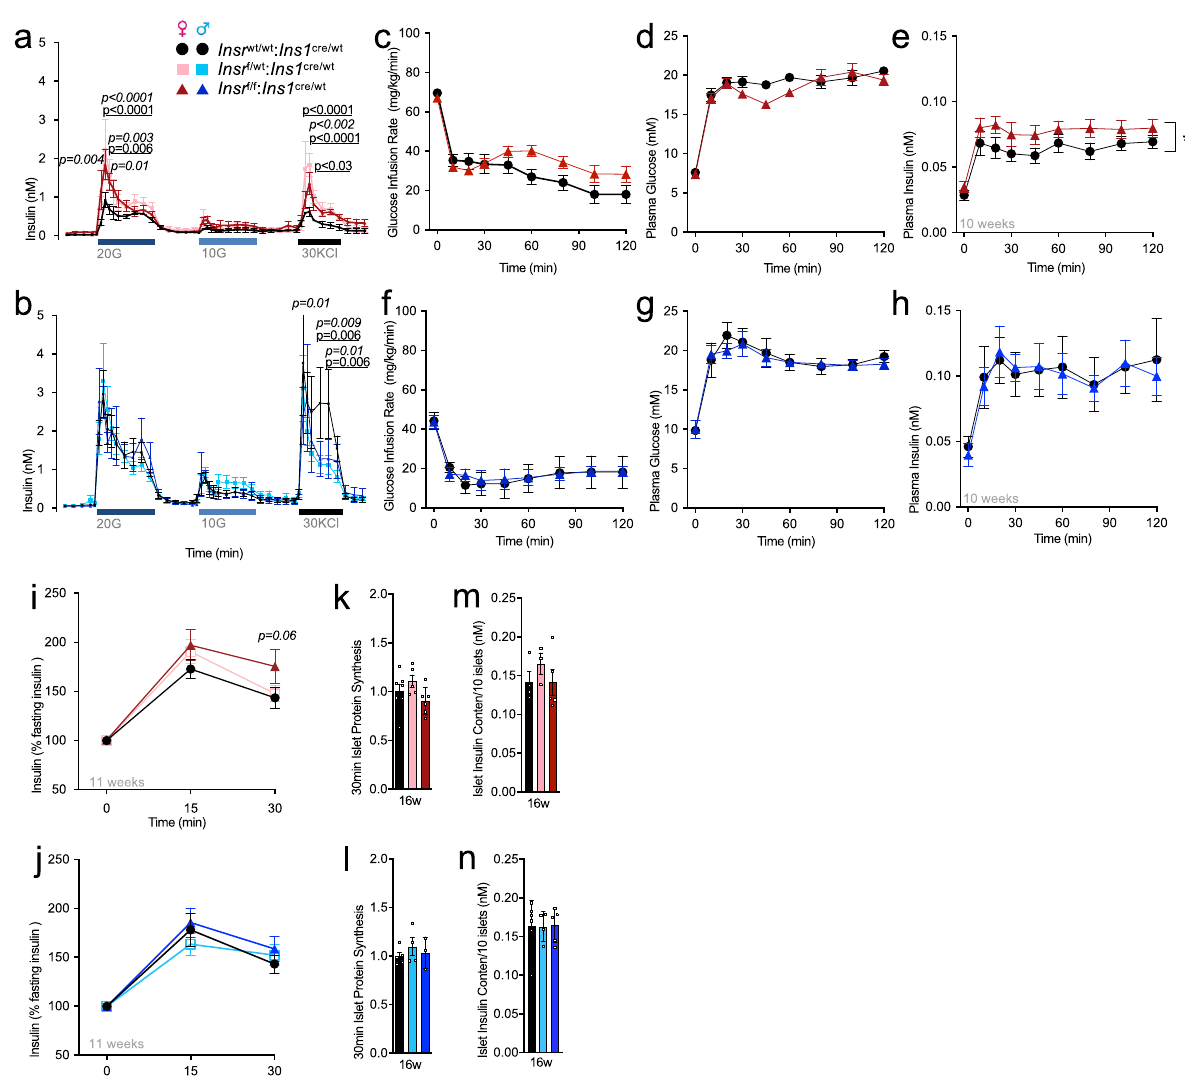
16 week old chow-fed control, β Insr HET , β Insr KO female (two parallel runs per n = 3, 3, 5), and male (2 parallel runs per n = 6, 5, 5) mice were exposed